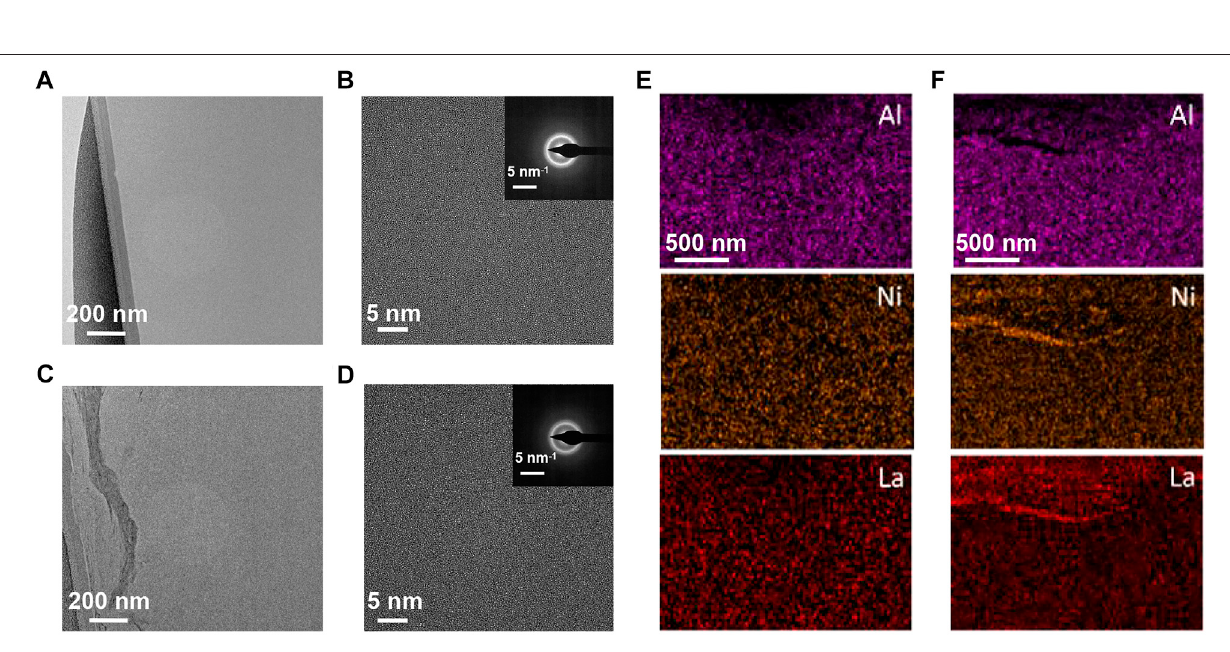
Frontiers in Materials |